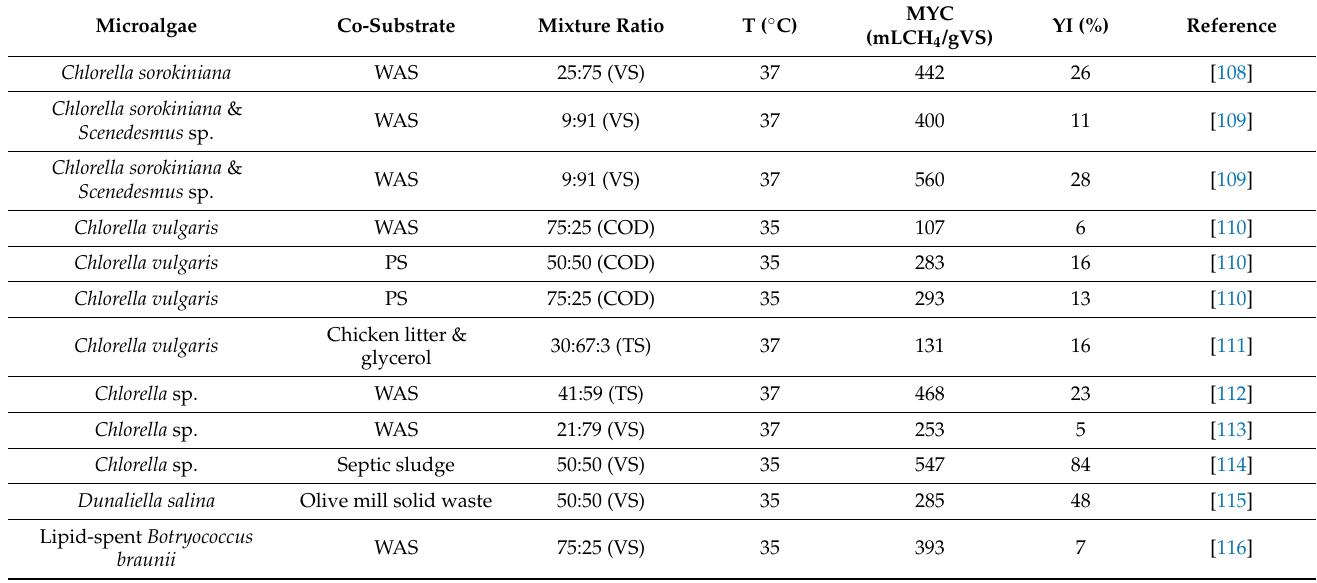
Table 5. Anaerobic co-digestion of microalgal biomass of different species for biogas production with various other